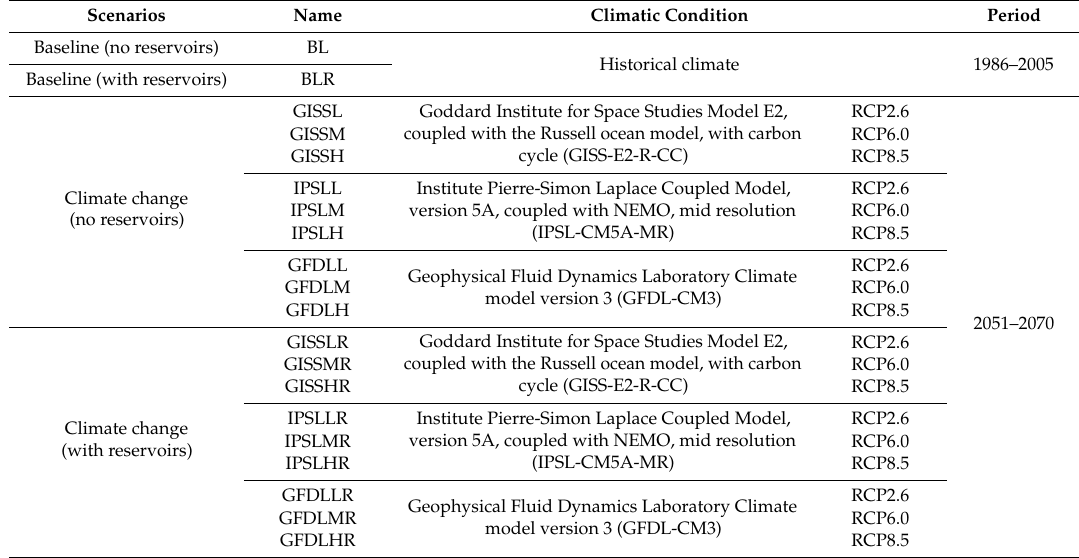
Table 2. Description of scenarios to assess impacts of climate change on hydropower